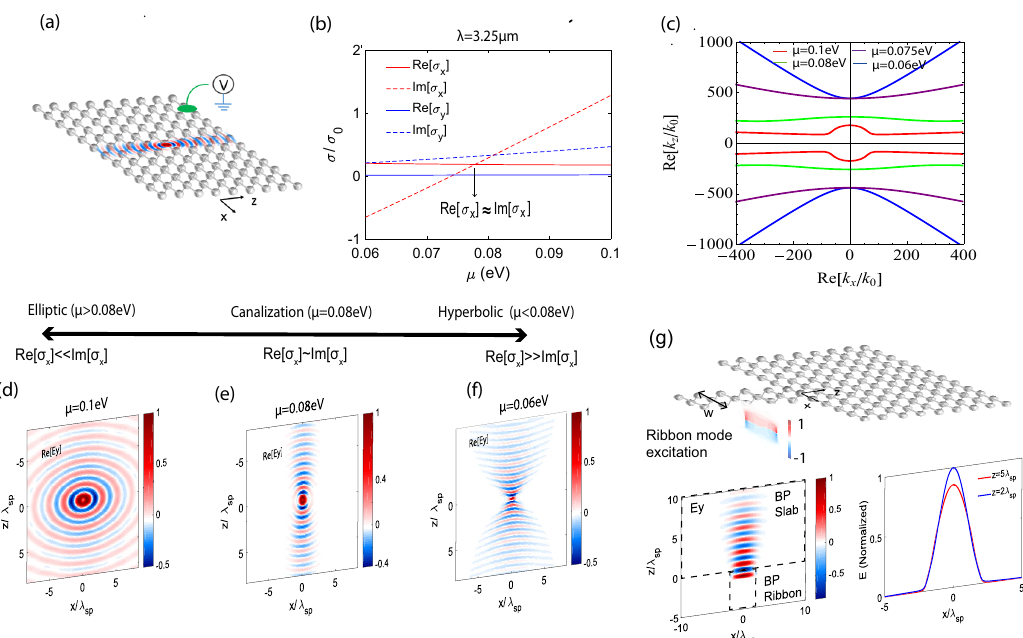
Fig. 4 BP as a gate-tunable 2D canalization platform. a Schematic of BP fi lm being considered for the realization of low-loss canalization fi eld tunable by bias or chemical potential. b Normalized conductivity tensor ( σ ¼ e 2 = 4 (cid:1) h ) in the armchair ( x ) and zigzag ( z ) directions for 0 20 nm BP as a function of chemical potential 23,24 when λ 0 ¼ 3 : 25 μ m . The conductivity of BP can be highly tunable where various material absorption level can be achieved via bias or chemical doping. In this case, moderate material absorption can be attained in BP when μ = 0.08 eV. c Material absorption-facilitated topological transition in BP when λ 0 ¼ 3 : 25 μ m . The dispersion contour can be elliptic, fl attened, and hyperbolic when, respectively, showing strong tunability over dispersion characteristics. The dispersion of BP under ENZ